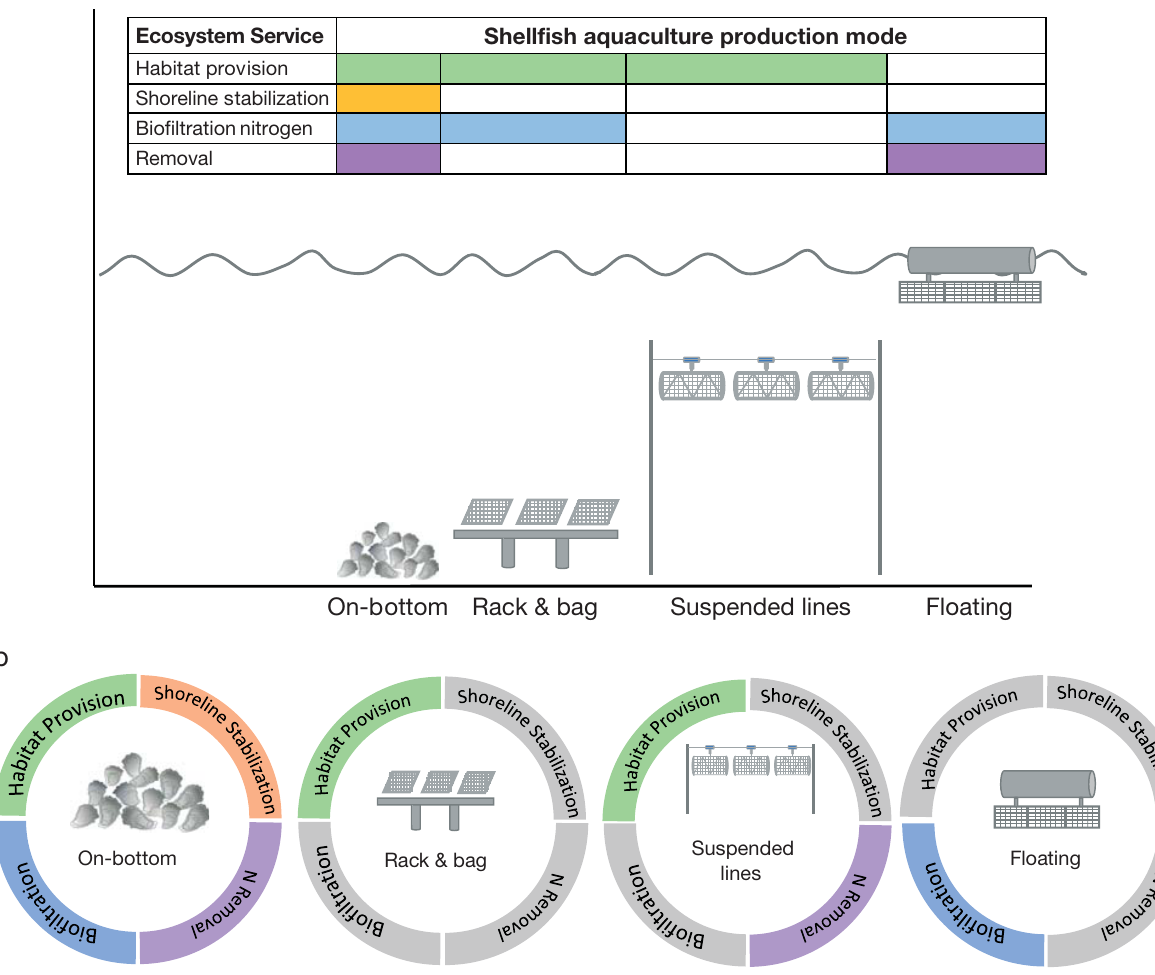
Fig. 1. (a) Culture methods of oyster shellfish aquaculture and ecosystem services suggested by the literature; (b) hypothetical gear-specific ecolabels. Brightly colored portions of circle segments indicate the ecosystem service is equal to or greater than natural oyster reefs, while grey segments indicate the ecosystem service is diminished or unknown, as indicated in Table